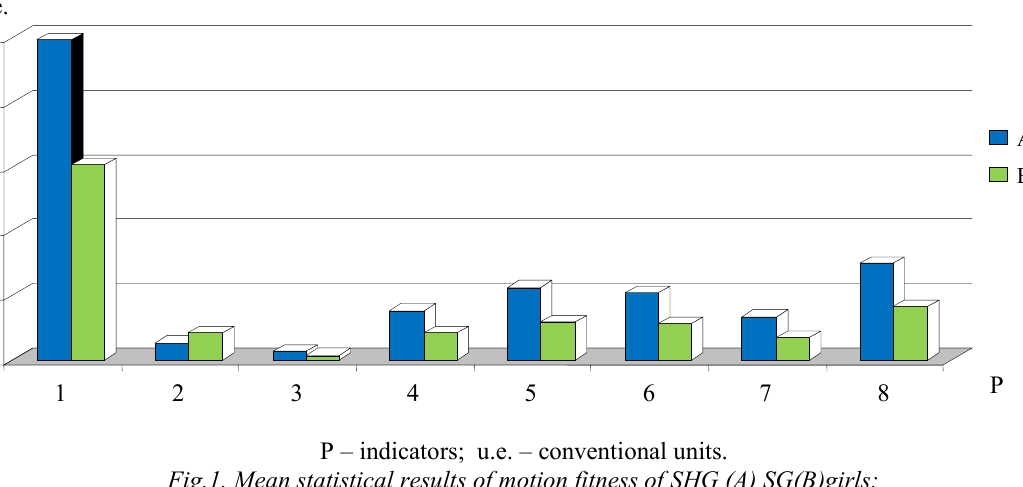
Fig.1. Mean statistical results of motion fitness of SHG (A)